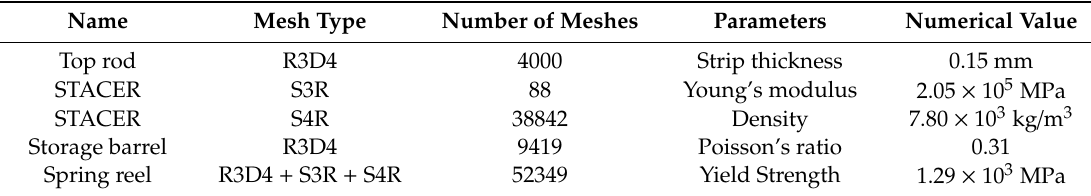
Table 1. Specification of the STACER numerical